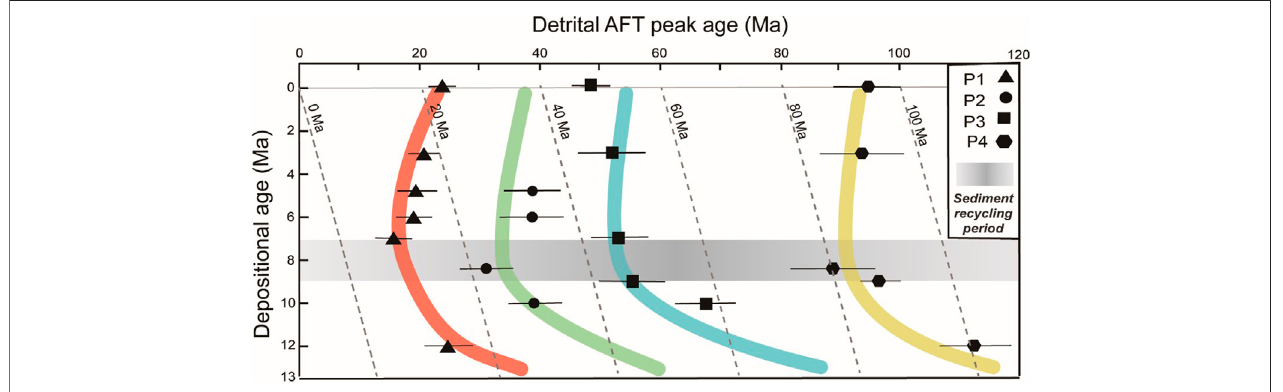
FIGURE 4 | Lag time plot of detrital AFT ages in the XB. Black symbols (P1 – P4) are component ages from this study. Dashed lines are the lag time contours with corresponding lag times labeled. The peak age trend shift (peak ages progressively decrease and then increase) occurred at ∼ 8 ± 1 Ma for P1, P2, P3, and P4, where each are considered to represent the time of a signi fi cant sediment recycling